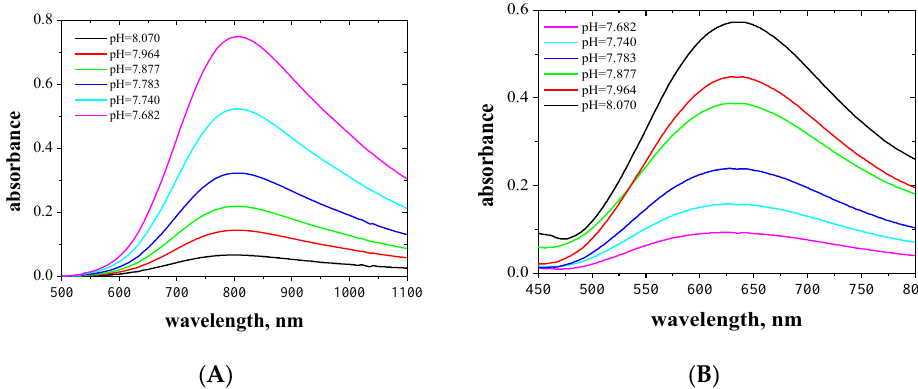
Figure 3. Absorption spectra of aqueous ( A ) and organic ( B ) phases after extraction of the Cu(II) complexes with EDAB-acac in methylene chloride together with the corresponding pH of the aqueous phase.